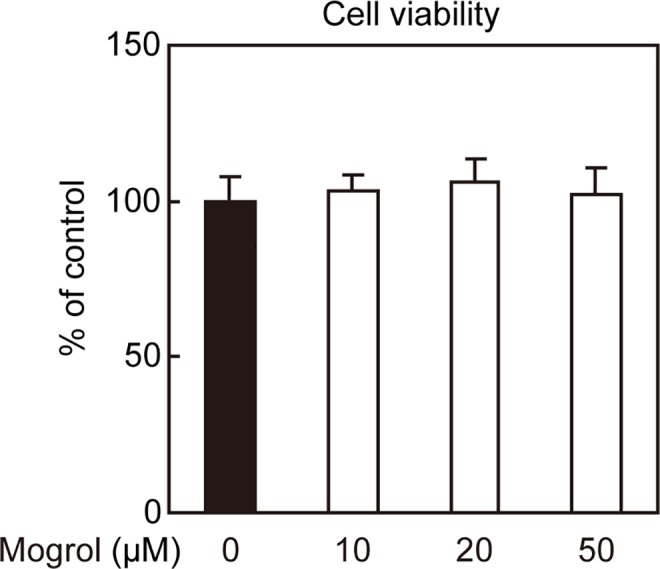
Effects of mogrol on the cell viability of 3T3-L1 preadipocytes.3T3-L1 cells were incubated in the presence the indicated concentrations of mogrol for 8 days. Medium with mogrol was exchanged every two days. After incubation with 5% AlamarBlue dye for 4 h, the cell viabilities were determined. Data represent the mean ± SD of a representative of three independent experiments with four replicates. No statistically significant differences were observed for the comparison with cells in the absence of mogrol (solid black bar) using one way ANOVA with Dunnett’s post-hoc test.